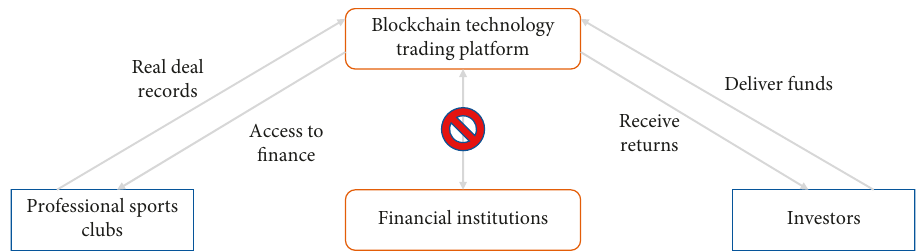
Figure 6: Guaranteed financing process for professional sports clubs based on blockchain technology.